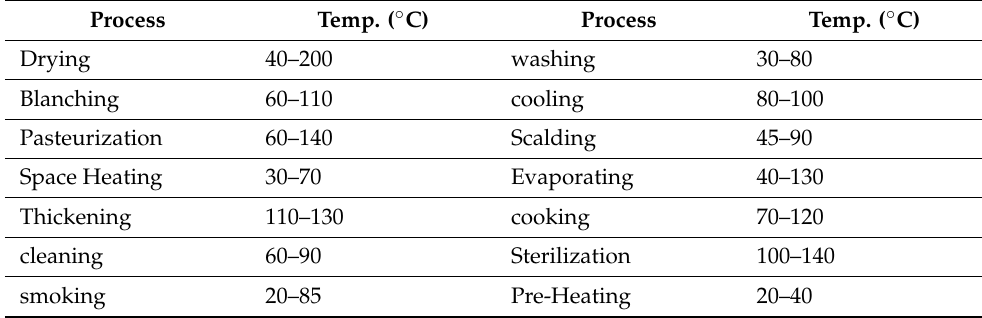
Table 2. Food industry processes [92,93].